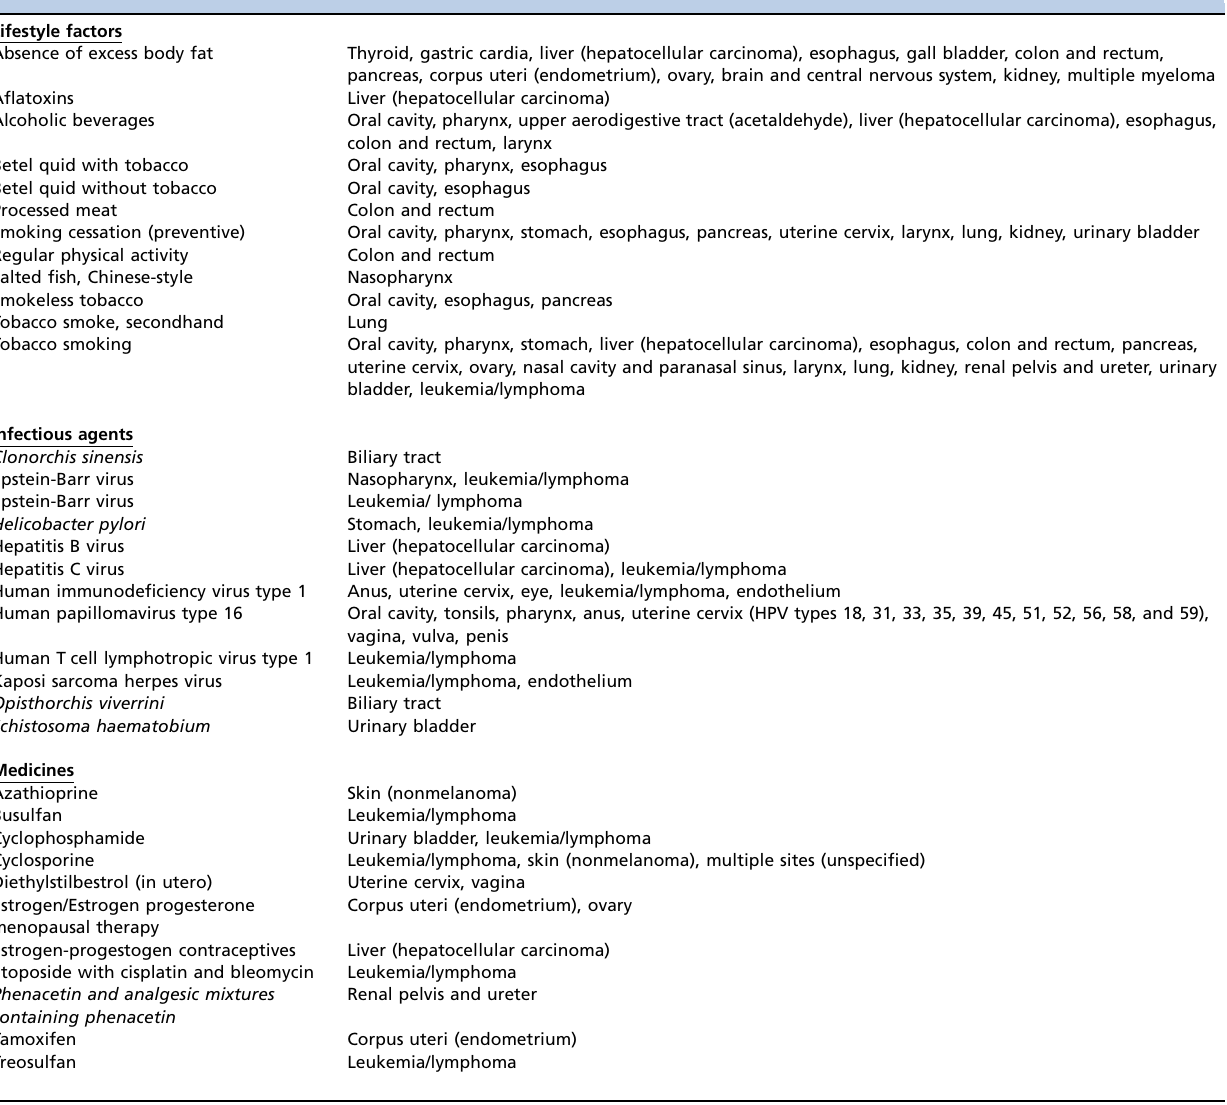
Table 1 - Risk and preventive factors classified as carcinogenic/anticarcinogenic in epidemiological studies and the subsites affected. Risk